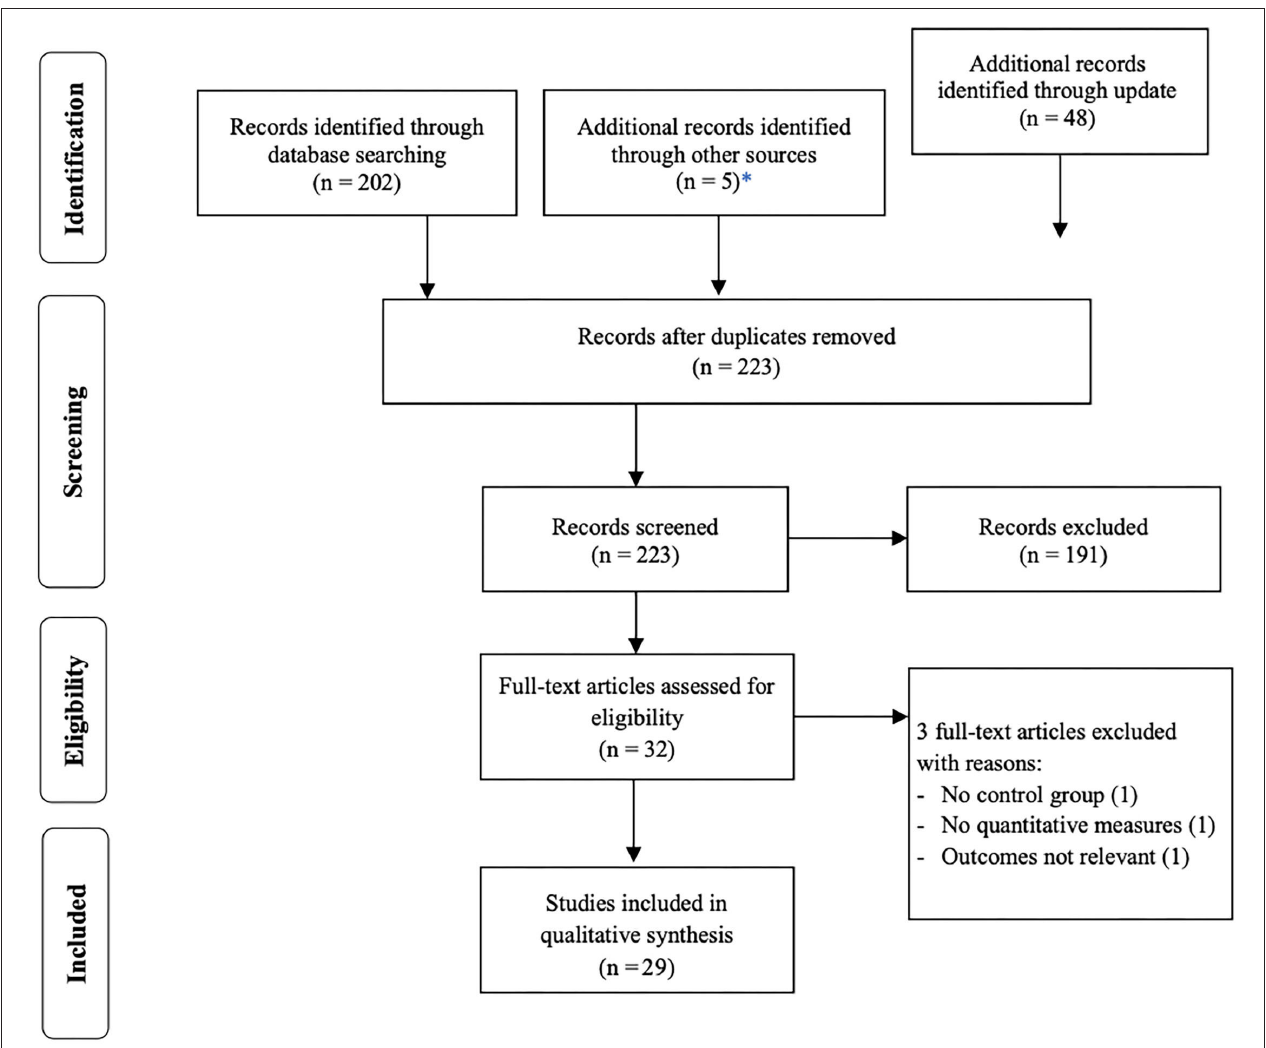
FIGURE 1 | Preferred Reporting Items in Systematic Reviews and Meta-Analyses (PRISMA) flow diagram of selection of studies. * Other sources for identification of further articles included Google Scholar and “snowballing” techniques such as searching non-indexed journals and references of all full-text